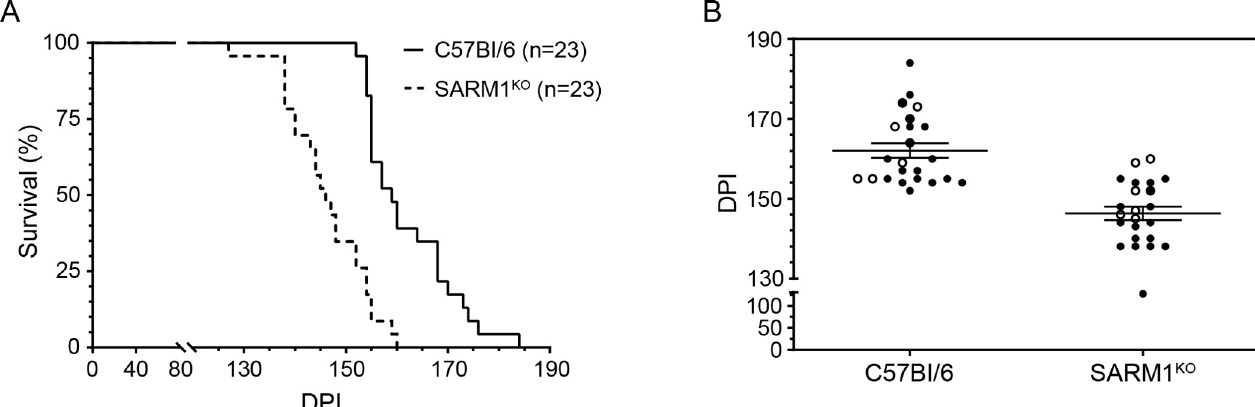
Fig 2. Decreased disease incubation times in SARM1 KO mice infected with RML prions. (A) Survival curves for C57Bl/6 (solid line) and SARM1 KO (dotted line) mice inoculated intracranially with RML prions. The number of mice inoculated is given in parentheses. (B) Scatter plot for SARM1 KO and C57Bl/6 mice inoculated intracranially with RML prions. Each circle represents one mouse and open circles indicate mice used in the Seahorse XFe96 mitochondrial coupling assay. Mean incubation times plus standard error of the mean (SEM) are indicated and are 162 ± 1.9 days for C57Bl/6 mice and 146 ± 1.7 days for SARM1 KO mice. Data are pooled from four independent experiments. Intercurrent deaths were excluded. Disease incubation times for C57Bl/6 and SARM1 KO mice differed significantly ( ���� , p < 0.0001, unpaired Student’s t-test). DPI = days post-infection.